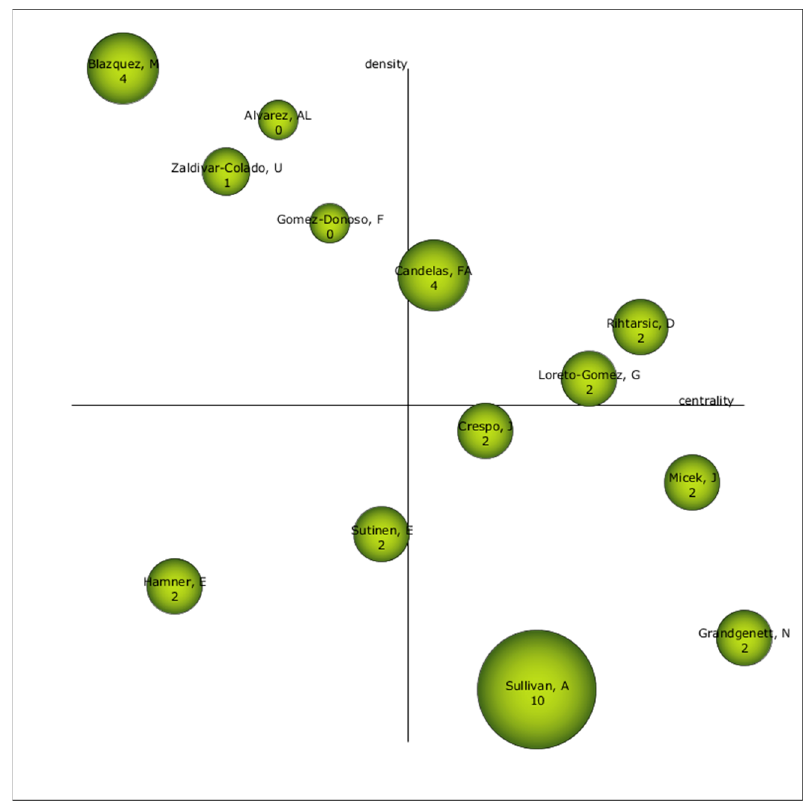
Figure 7. Strategic author diagram of the entire production.